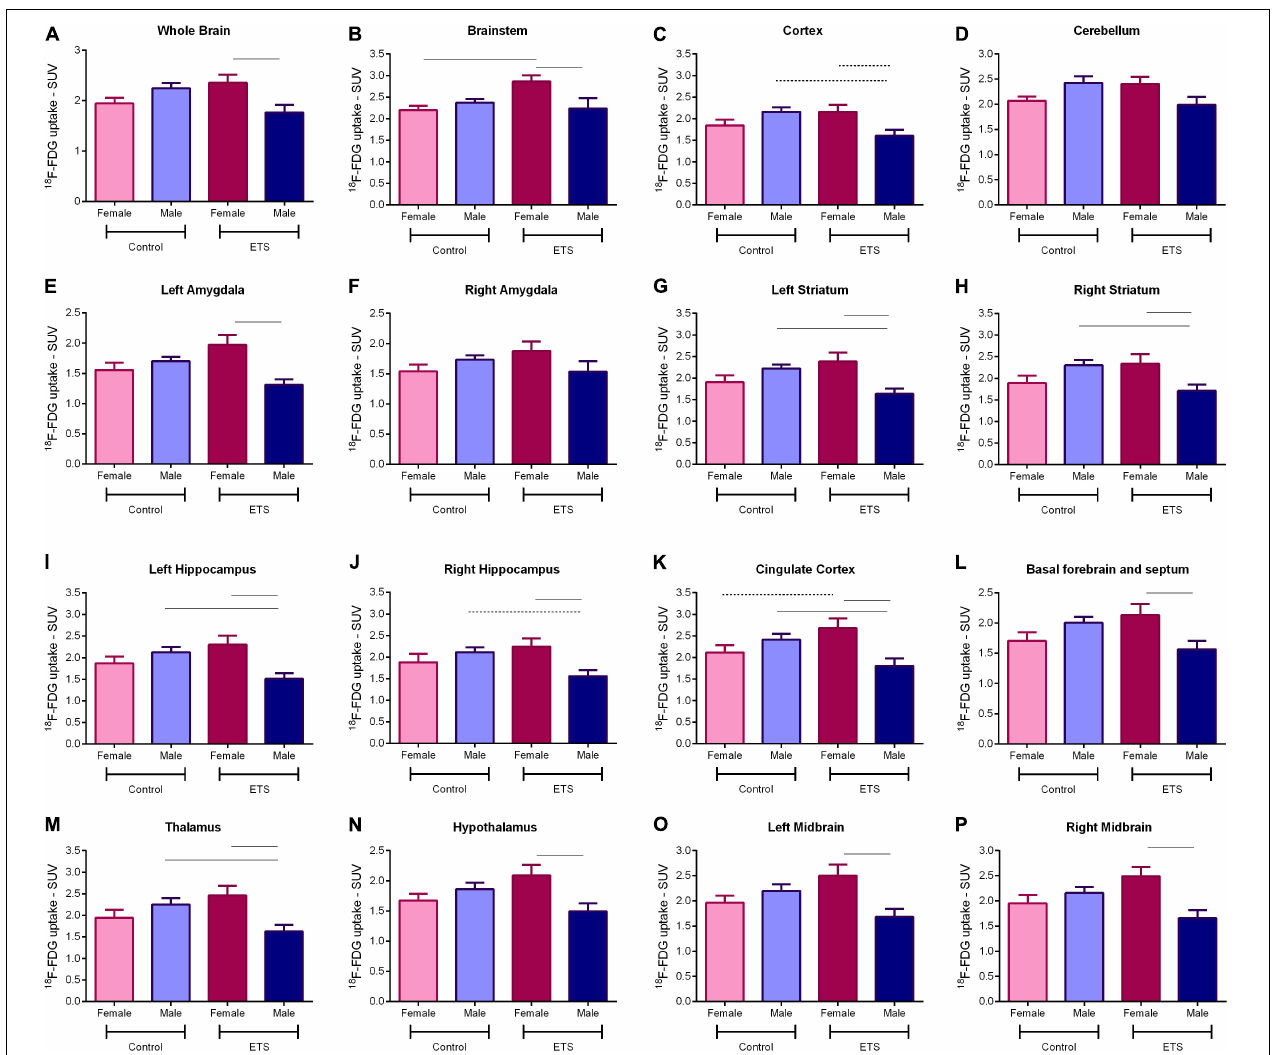
FIGURE 3 | 18 F-FDG uptake for adult mice ( n = 5 females ETS-exposed and n = 4 females control; n = 5 males ETS-exposed and n = 5 males control) in the whole brain (A) , brainstem (B) , cortex (C) , cerebellum (D) , left amygdala (E) , right amygdala (F) , left striatum (G) , right striatum (H) , left hippocampus (I) , right hippocampus (J) , cingulate cortex (K) , basal forebrain and septum (L) , thalamus (M) , hypothalamus (N) , left midbrain (O) , and right midbrain (P) . Two-way ANOVA with Bonferroni post hoc test and adjusted p -values for multiple comparisons. Continuous bar: p < 0.05. Dashed bar: trend toward statistical